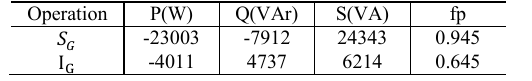
Table VIII. Active, Reactive and Total Power and Power Factor in 𝑀 1 𝑓𝑜𝑟 𝑁 𝐿 . Configuration